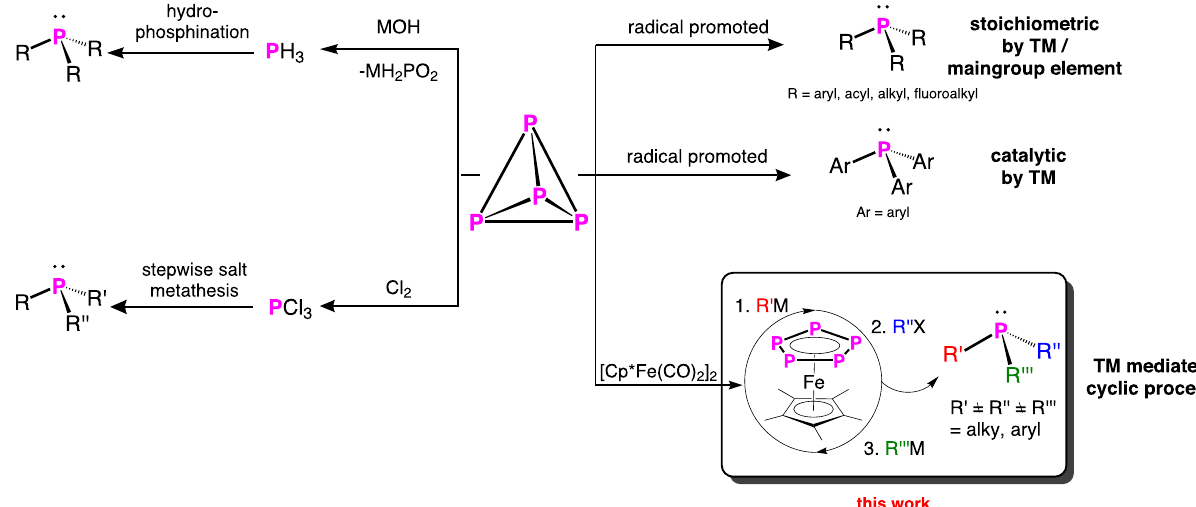
Fig. 1 Different approaches for the synthesis of ternary phosphines. Left: conventional way, hydrophosphination and salt metathesis. Right: Radical promoted, stochiometric and catalytic, as well as the ‘ semi-catalytic ’ transition metal (TM) mediated synthesis of ternary